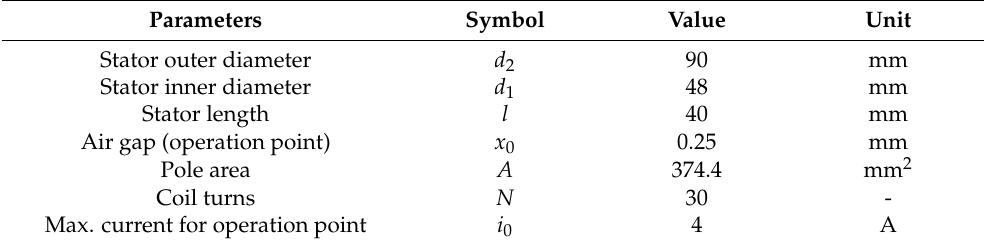
Table 1. Basic parameters of the